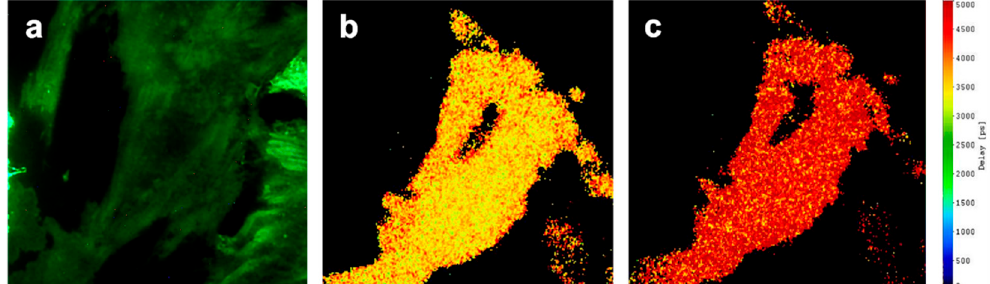
Figure 6. ( a ) TIR fluorescence intensity of the Epac sensor in CHO ‐ K1 cells in the spectral range λ ≥ 470 nm, and ( b , c ) fluorescence lifetime of the donor CFP measured upon TIR excitation in the spectral range of 450–490 nm at 0 s ( b ) and 10 s ( c ) subsequent to addition of Forskolin (image size; 100 μ m × 100 µ m); scale in picoseconds.